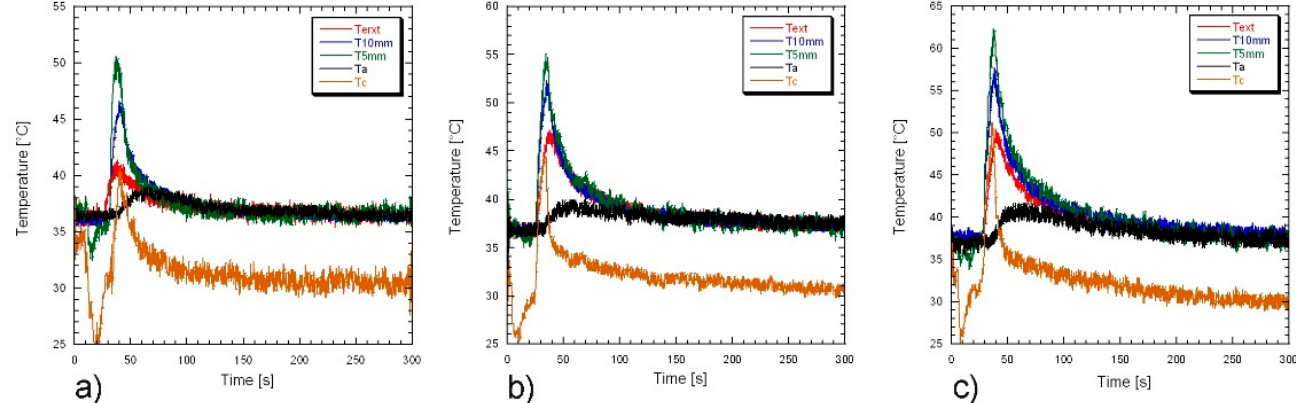
Figure 5. Temperature profiles in different regions of the tooth by heating sodium-hypochlorite through the XF-30/04 plugger using temperature set at 100 ◦ C ( a ), 150 ◦ C ( b ), and 180 ◦ C ( c ). 3.2.3. ML-12